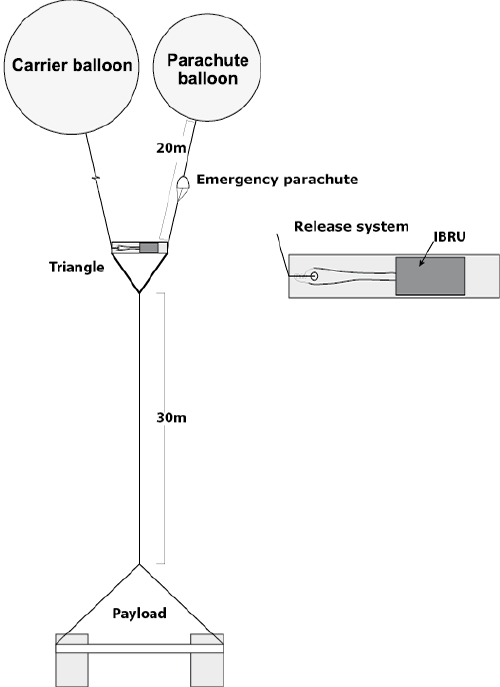
Figure 6. Double balloon sounding configuration with carrier and parachute balloon connected to the payload via the triangle that in- cludes the IBRU release